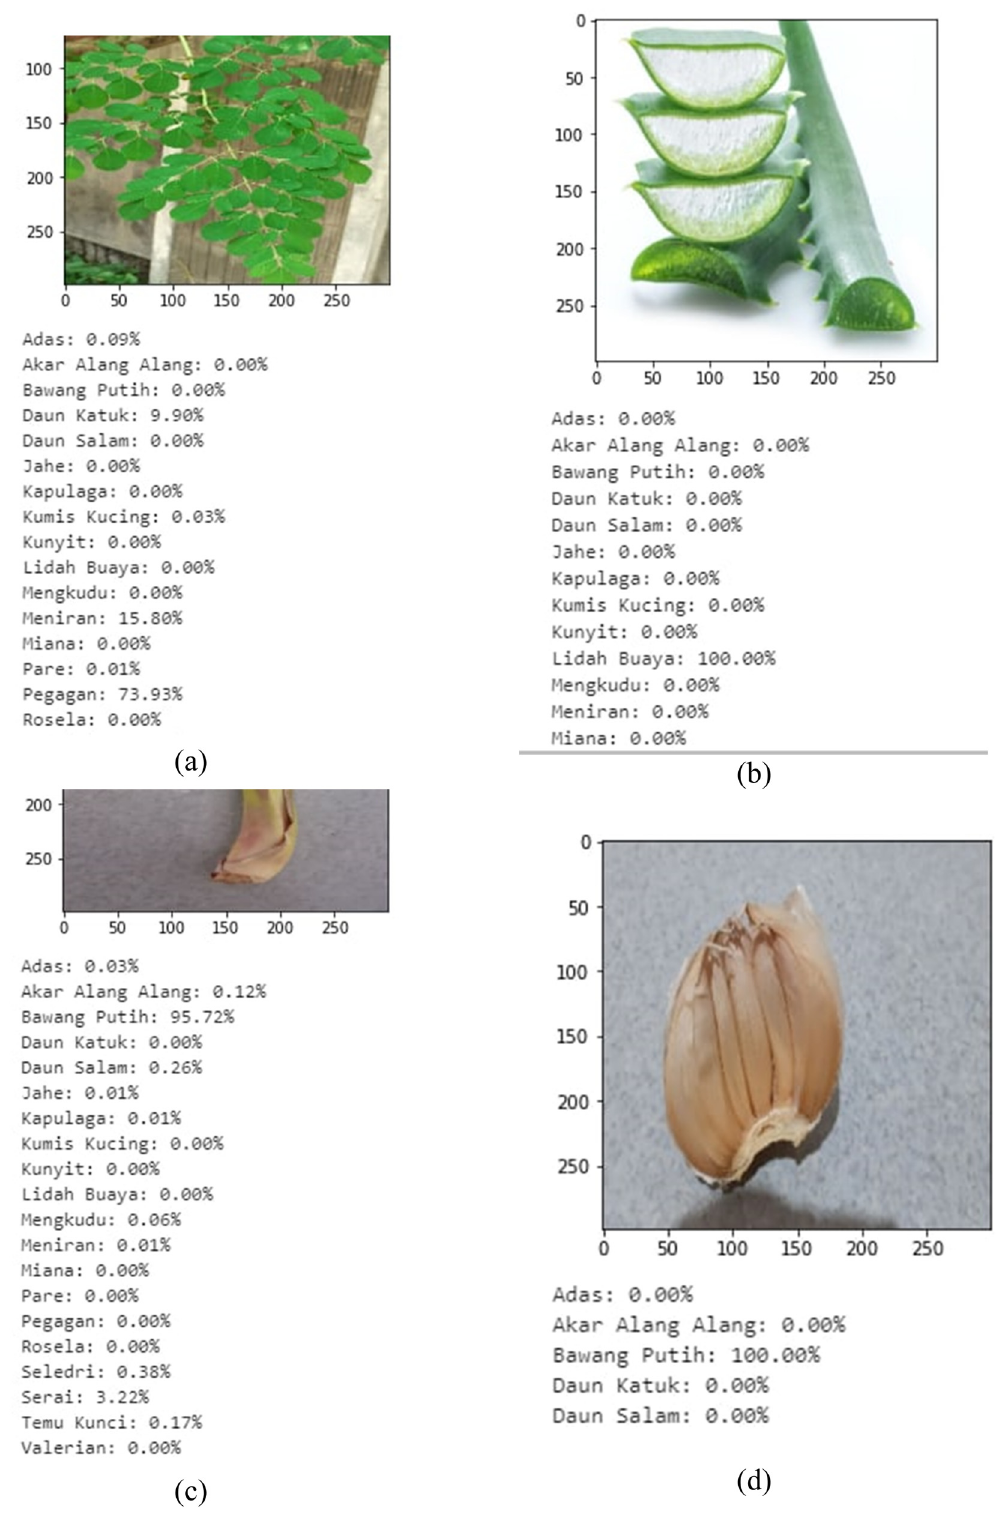
Figure 9: The results of the con fi dence model number with the input of testing images: ( a ) Pegagan leaves, ( b ) Aloe vera, and ( c and d )